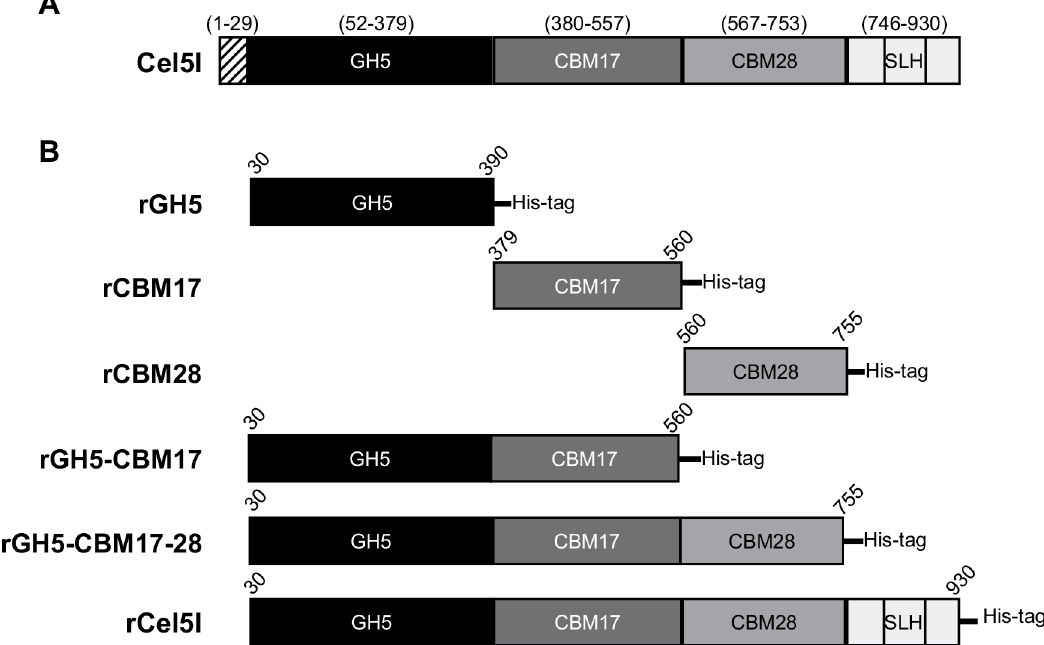
Fig 1. Domain organization of Cel5I and recombinant proteins produced. A. Prediction of domains and their boundaries in Cel5I from Ruminiclostridium cellulolyticum , according to Signal P, Superfamily and Prosite. Numbers above the protein correspond to the first and last amino acids of each predicted module according to the sequence of the full-length molecule. B. Modular organization of recombinant proteins produced in the present study. Numbers above the protein correspond to the first and last amino acids of each recombinant protein according to the sequence of the full- length protein.